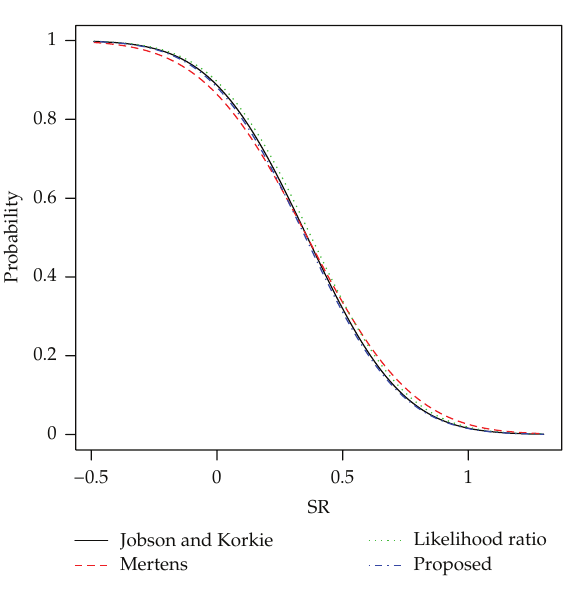
Figure 1: p value function for Fund.